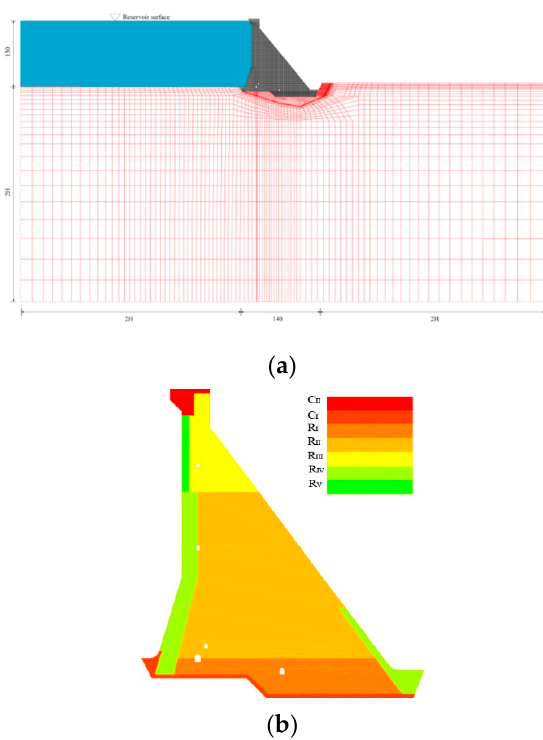
Figure 1. Finite element model of Guandi concrete gravity dam: ( a ) dam-foundation system; ( b ) materials of the dam